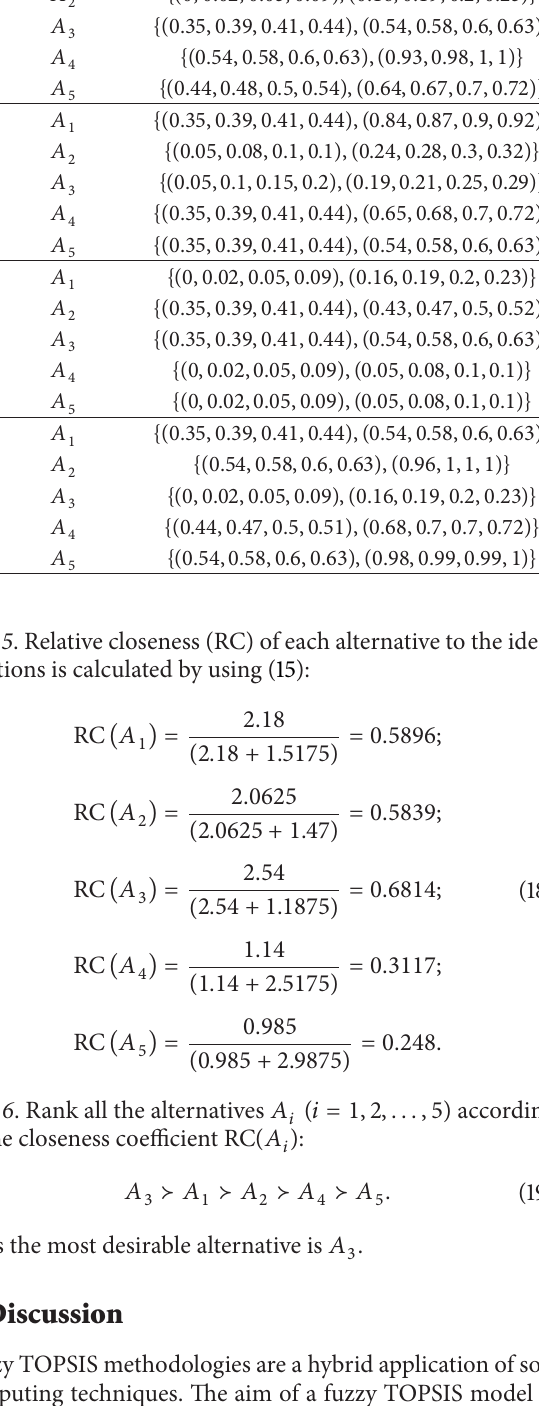
̃𝑋 3 ) with respect to decision makers 7 and